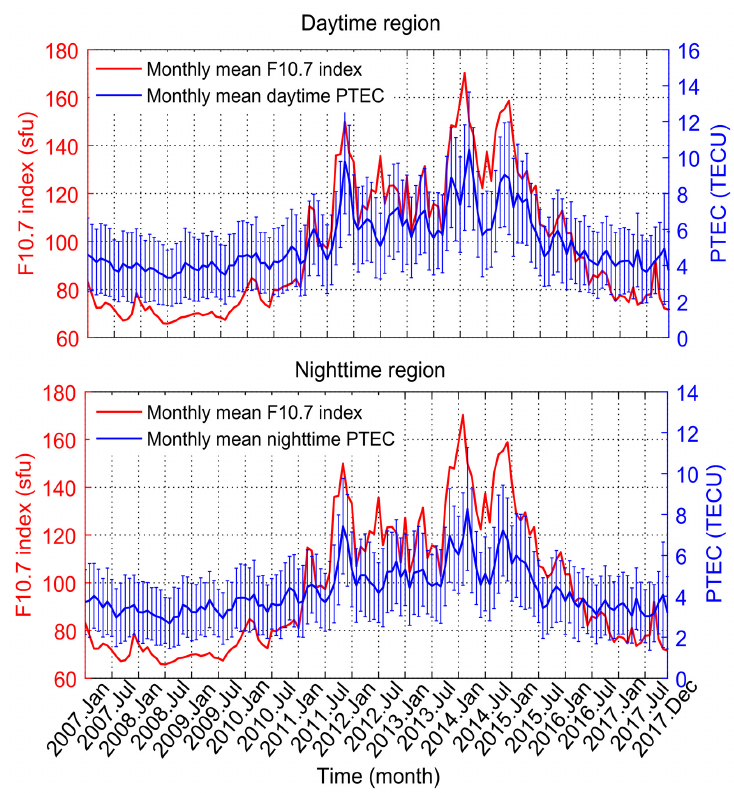
Figure 12. Monthly mean F10.7 index and monthly mean daytime and nighttime PTEC from January 2007 to December 2017. To further estimate the correlation between PTEC and the F10.7 index, we divided the monthly plasmaspheric TEC into latitudinal regions according to the geomagnetic lat- itude and the magnetic local time, and the criteria of division are the same as mentioned before. The monthly mean PTEC for each geomagnetic latitudinal region was calculated for daytime and nighttime. Then, they were counted with the corresponding monthly mean F10.7 indices in different subgraphs in Figure 13. There are strong correlations be- tween the monthly mean F10.7 indices and the monthly mean daytime and nighttime PTEC in each latitudinal region. In the same geomagnetic latitudinal region, the correla- tion between the monthly mean PTEC and the monthly mean F10.7 indices in the daytime is higher than that in the nighttime. This is because the plasmasphere in the daytime is directly exposed to the sun and can receive solar radiation and the energy directly, while in the nighttime, the plasmasphere is more affected by the ionosphere, which reduces the